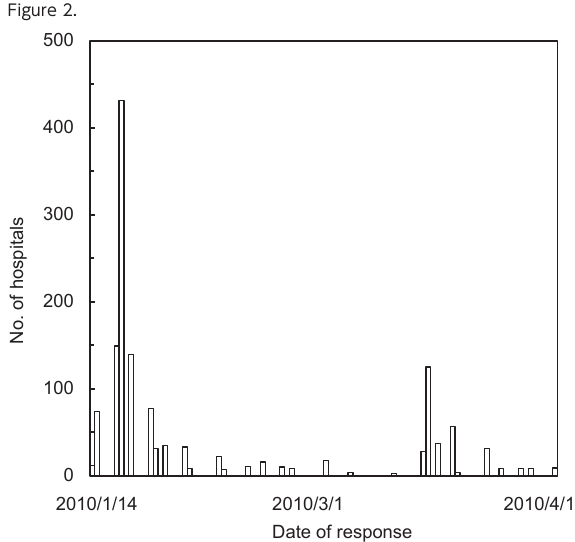
Distribution of the dates on which hospitals responded to the nationwide epidemiological survey of familial Mediterranean fever.